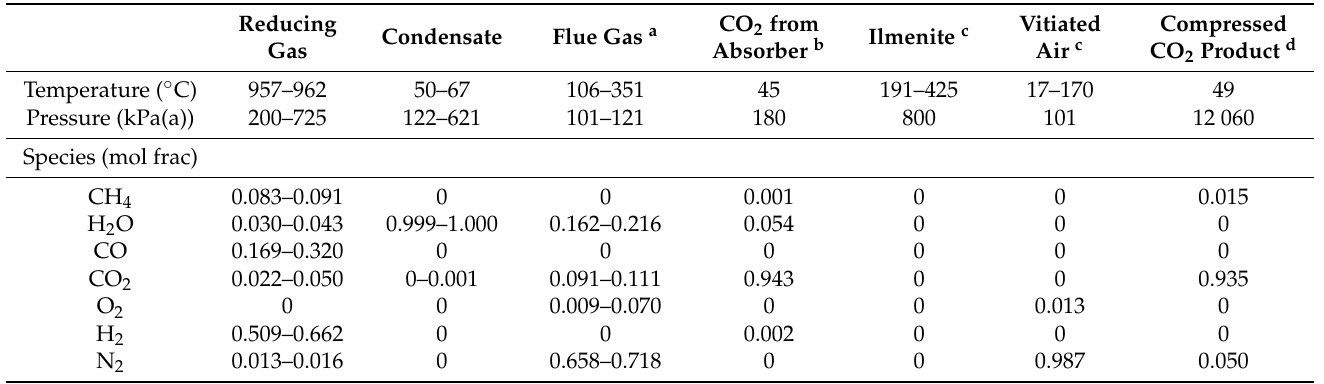
Table 3. Properties of products in base case and PCL-DRI process